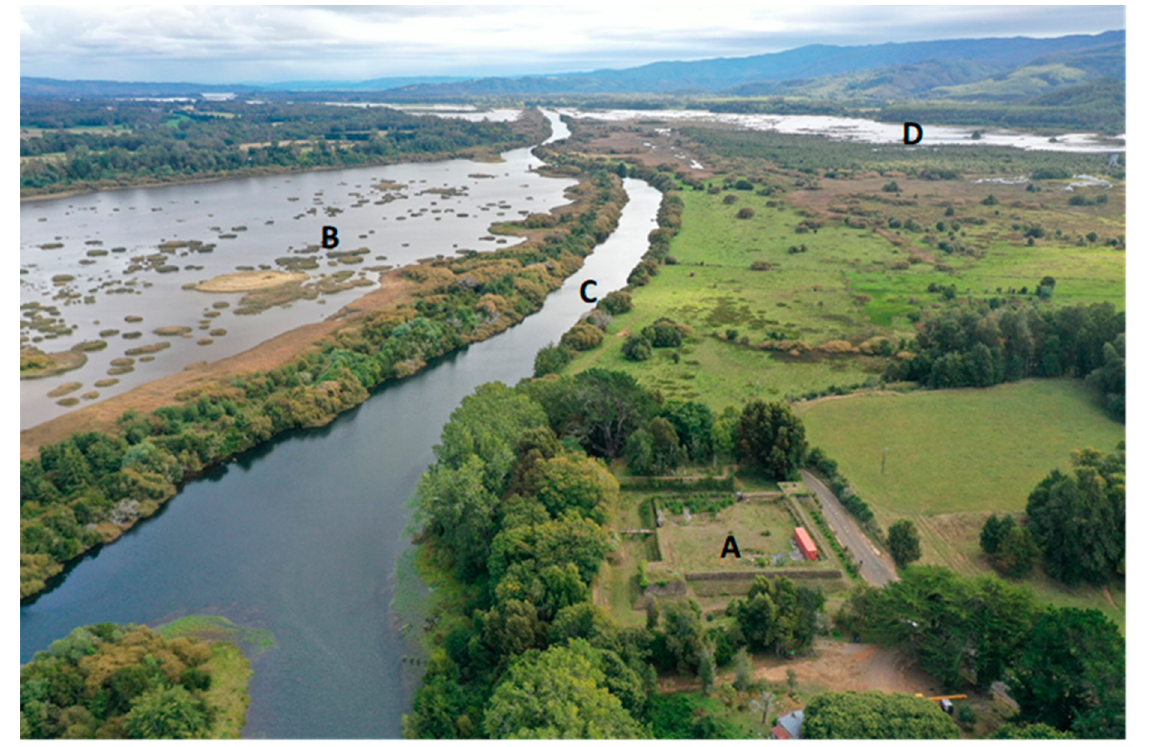
Figure 3. Image obtained during fieldwork in the San Luis del Alba area, March 2022. ( A ). San Luis del Alba Fort. ( B ). Cruces River. ( C ). San José River, ( D ). Ralicura River.